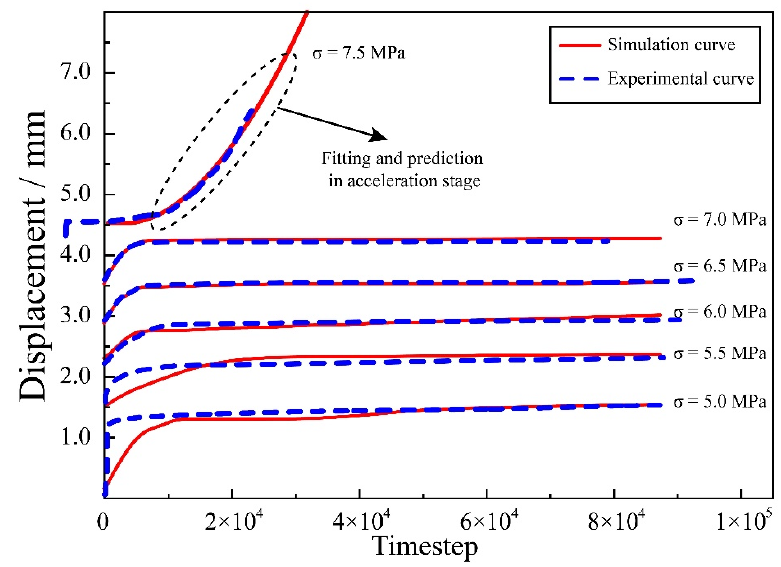
Figure 16. The comparison between experimental curve and simulation curve.